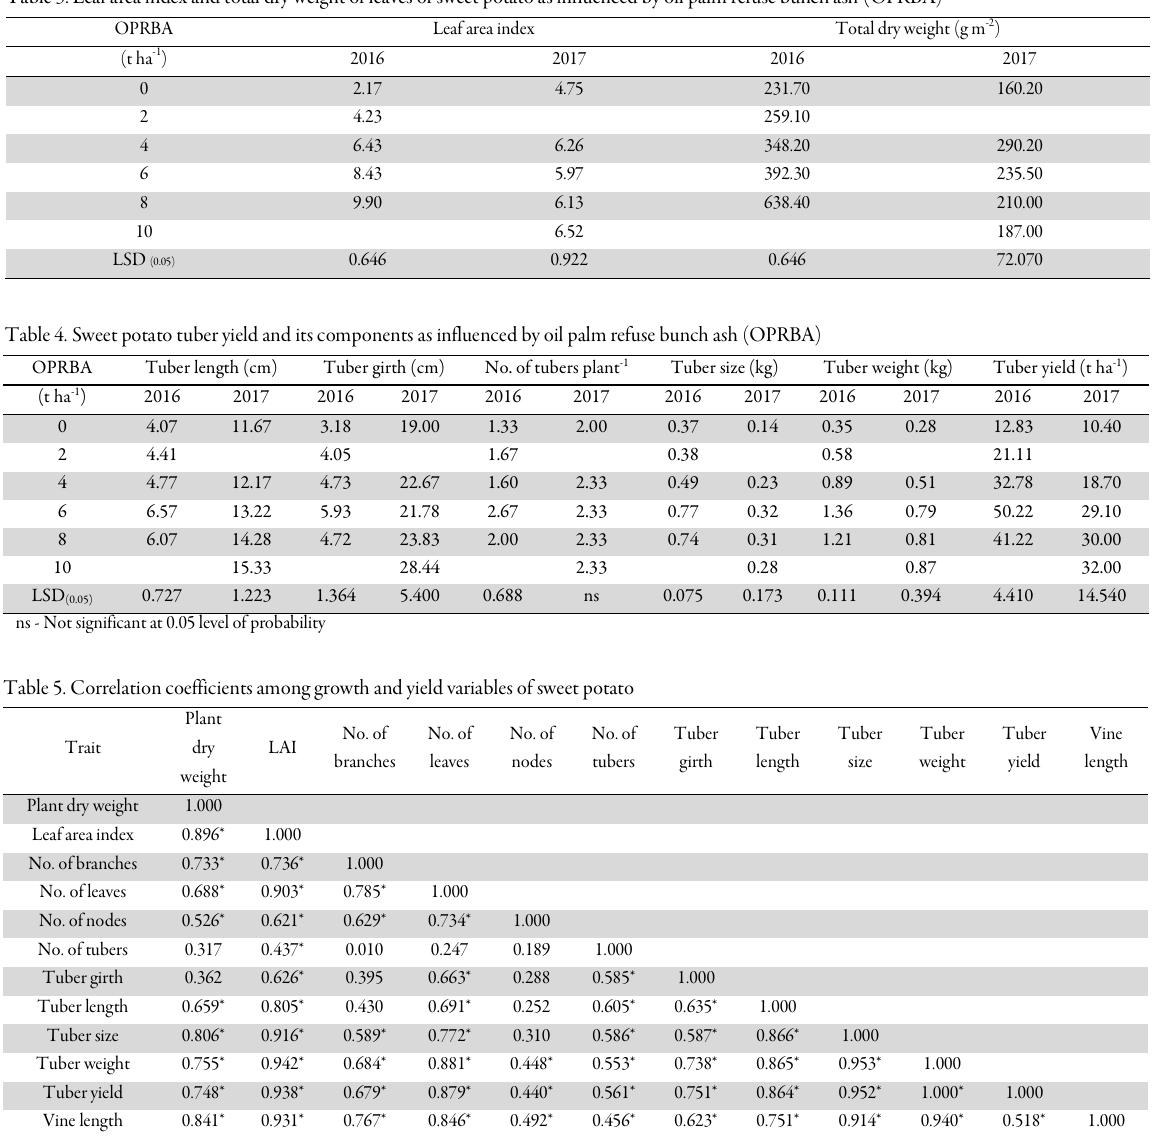
Table 5. It was observed that total dry weight had significant (p < 0.05) and positive relationship with the vine length,